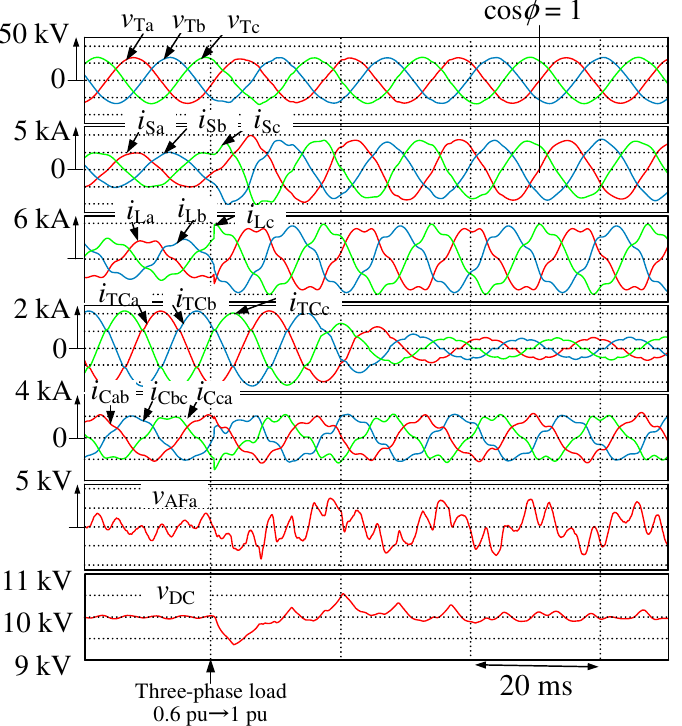
Figure 11. Simulation waveforms for Figure 4 with the three-phase load variation from 0.6 to 1 pu, when the control gain K C was 30 Ω